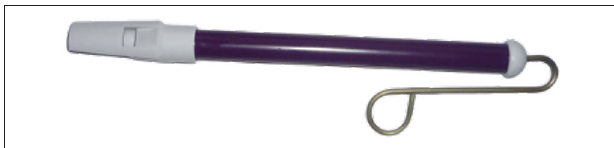
FIGURE 1 | Slide whistle (reproduced with permission from Verhoef,